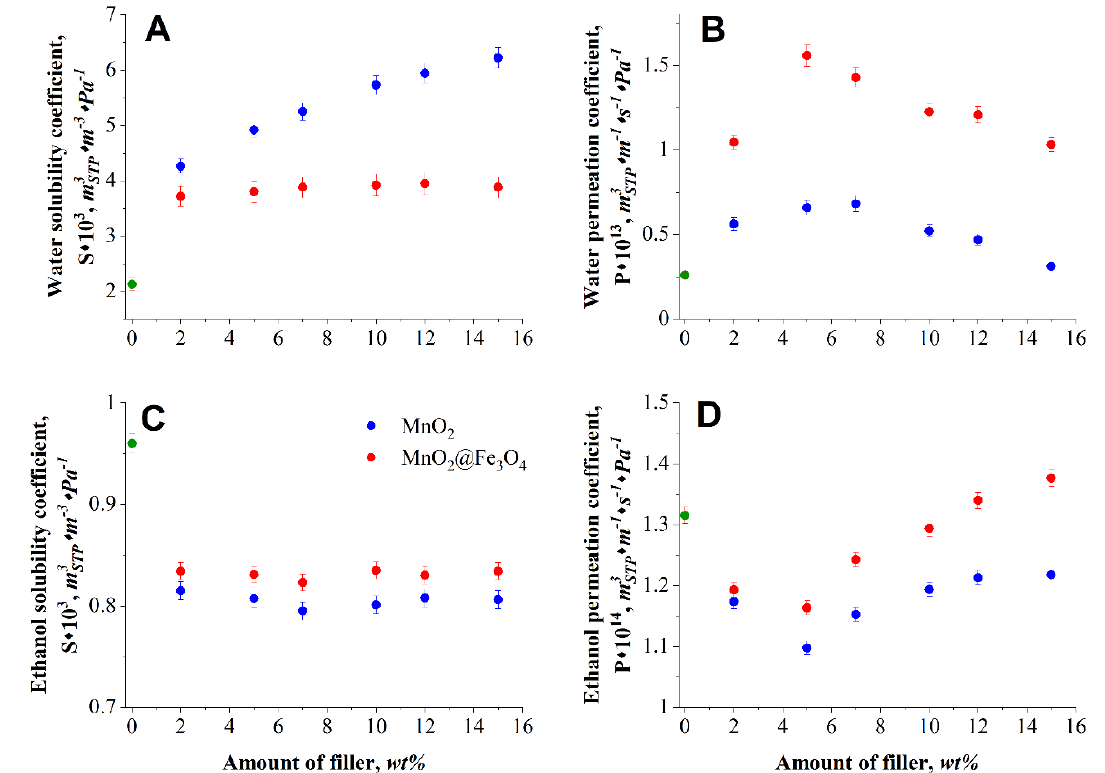
Figure 6. Calculated transport coefficient for alginate membranes filled with MnO 2 and MnO 2 @Fe 3 O 4 : panel ( A )—water solubility coefficients; ( B )—water permeation coefficients; ( C )—ethanol solubility coefficients; ( D )—ethanol permeation coefficients.